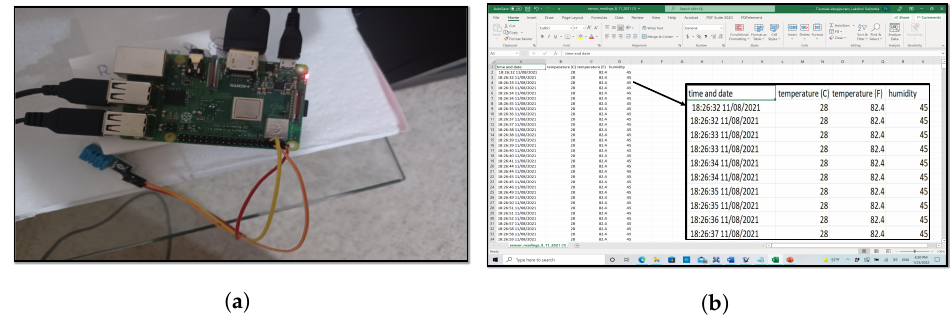
Figure 8. Sensor data. ( a ) IoT-Edge device. ( b ) IoT-Edge device data in CSV